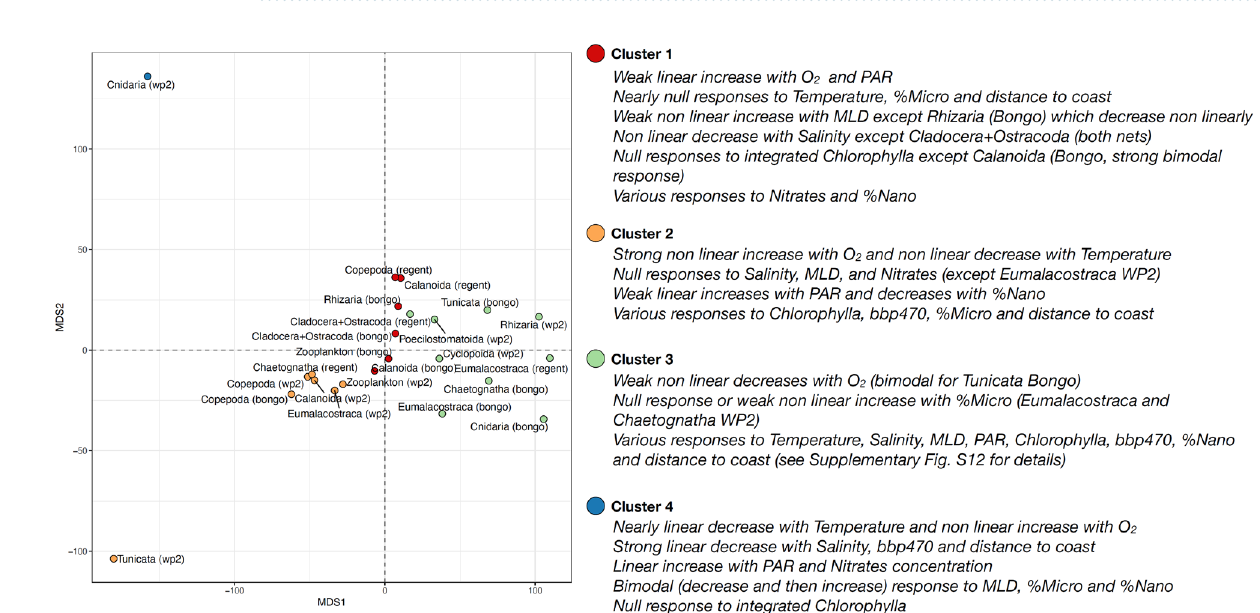
Figure 5. Two dimensional metric dimensional scaling (MDS) plot illustrating the similarity between the responses of the groups ’ median ESD to the environmental covariates selected. The smoothing curves from the Generalized Additive Models (GAMs) modelling the global gradients in log-transformed median Equivalent Spherical Diameter (ESD, µm) of the zooplankton groups (estimated for various plankton nets) as a function of ten environmental covariates and displaying a deviance explained > 40%. The smoothing curves were combined into a multivariate data series to compute Dynamic Time Warping (DTW) distances and perform partitioning around medoids (PAM) clustering. This way the GAMs were clustered into four clusters representing combinations of zooplankton groups and plankton nets that exhibit similar median ESD-covariate